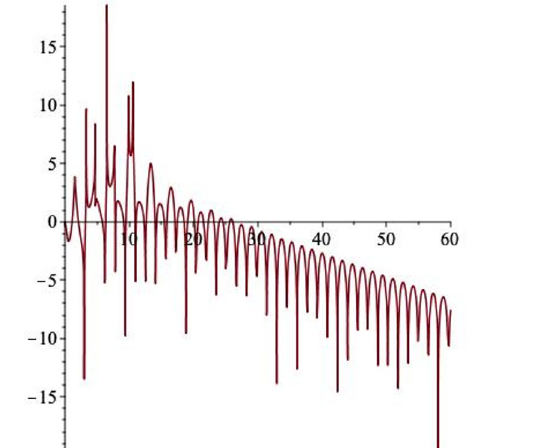
(cid:16) (cid:17) (cid:16) ˙ (cid:15) 2 (cid:17) ˙ (cid:15) 2 x /(cid:15) (left) and ln (right) versus affine parameter for a geodesic y /(cid:15) ˙ (cid:15) 2 /(cid:15) 2 ˙ (cid:15) 2 /(cid:15) 2